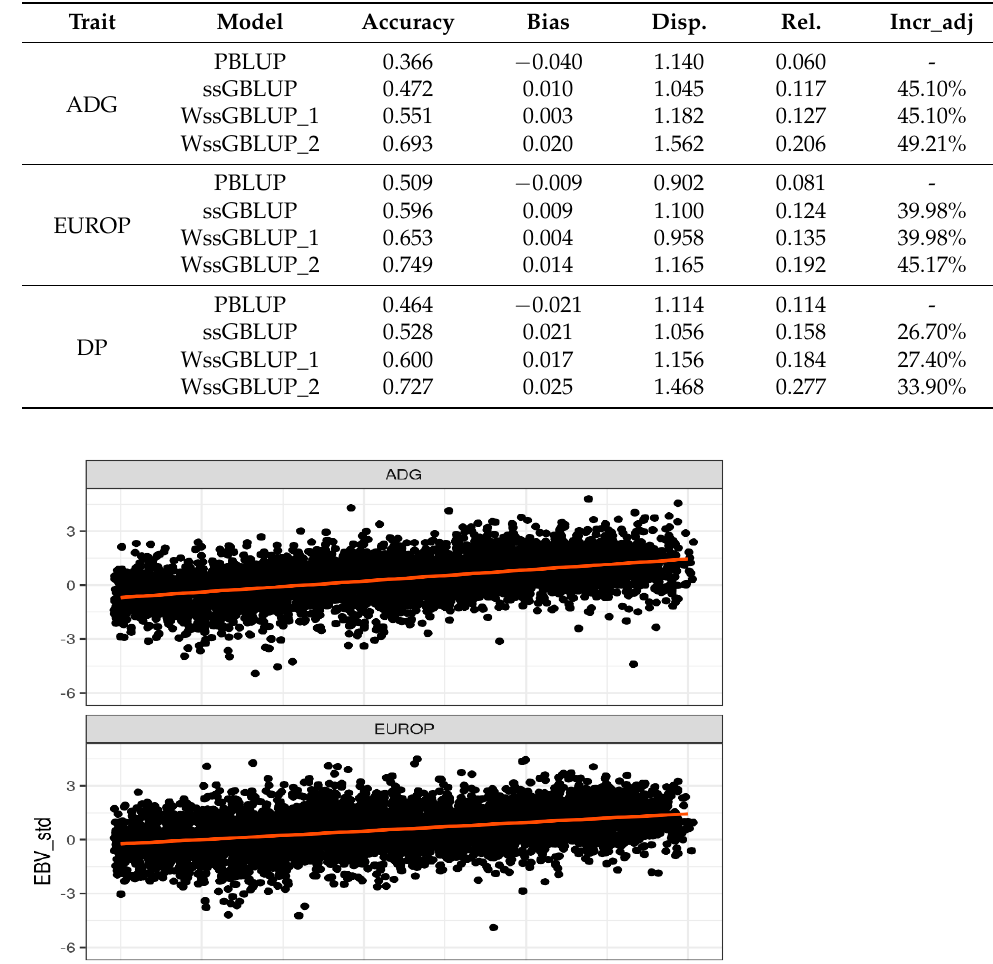
Table 4. Accuracy, bias, dispersion (Disp.), and reliability (Rel.) and adjusted increased of accuracy (Incr_adj) of estimated breeding values under different models: pedigree BLUP (PBLUP), single- step genomic BLUP (ssGBLUP), and weight single-step with bias value closet to optimal value